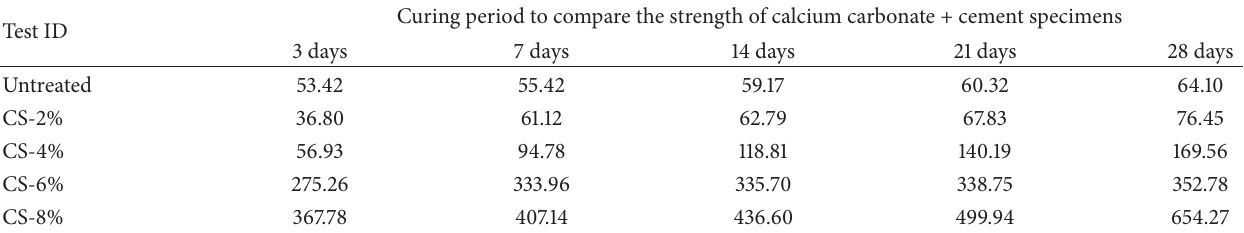
Figure 7: Effect of enhancing strength of calcium carbonate specimens. Table 5: Curing period to compare the strength of calcium carbonate + cement specimens (unit: